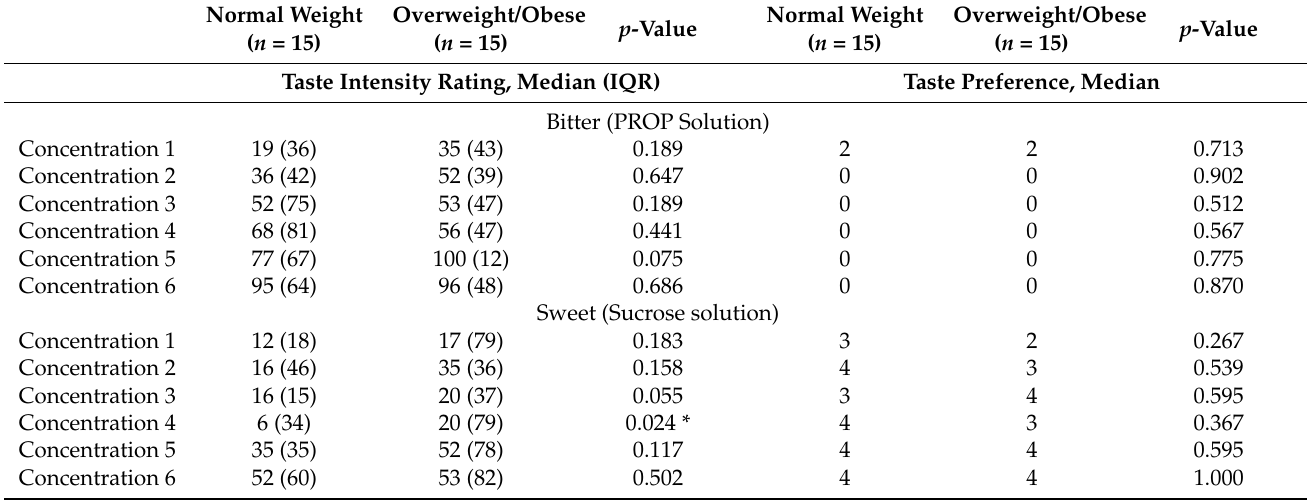
Figure 2. Boxplot of median taste identification scores for bitter and sweet between normal-weight and overweight groups. Overall, no significant differences in taste preference for both stimuli (sweet and bitter) were observed between the study groups for each concentration ( p > 0.05 in all cases) (Table 2). When determining taste intensity using the LMS scale, a higher score indicated that a stronger taste intensity was perceived, with a maximum score of 100. No significant differences between the study groups were observed in rating the concentrations of PROP solutions ( p > 0.05 in all cases) (Figure 3). An inverse relationship between bitter taste intensity and preference scores was observed in both groups, wherein a higher intensity rating was associated with a lower preference score (Table 3). Both groups disliked the PROP solution at concentrations beyond Concentration 2. Table 2. Comparison between median taste sensitivity score and food preference score between the study groups.